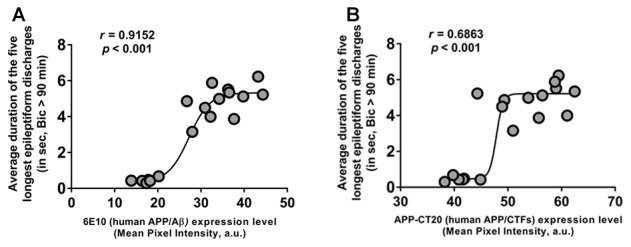
Positive correlation of intraneuronal human APP/Aβ expression in CA3 neurons and ictal-like activity in CA3 region.
(A,B) Correlation analyses revealed a positive relationship between intraneuronal human APP/Aβ immunoreactivity in the CA3 neurons (analyzed by 6E10, human APP/Aβ (A) and by APP-CT20, human APP/CTFs (B)) and average duration of the five longest epileptiform discharges recorded during a 5-min period after 90 min of bicuculline application in CA3 region of hippocampal slices from the same mice. Data from Saline-3xTg-AD (n = 9) and 6E10–3xTg-AD (n = 9) was pooled together to evaluate the correlations depicted in (A,B). The sigmoidal curves based on non-linear regression are also shown.